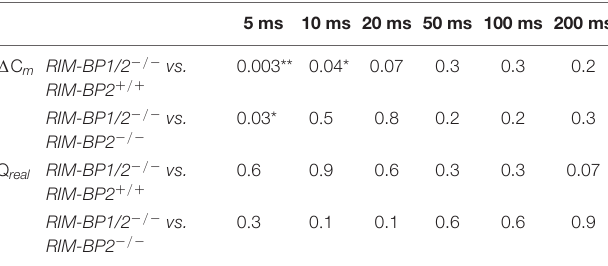
Summary of statistical analysis of patch-clamp measurement data ( Figure 2B ): Membrane capacitance changes ( (cid:49) C m , upper columns) and the corresponding whole-cell Ca 2 + -current integrals (Q Ca , lower columns) during various depolarization durations (5–200 ms) were compared between IHCs of different genotypes: RIM-BP1/2-deficient (RIM-BP1/2 − / − , n = 8), RIM-BP2-deficient (RIM-BP2 − / − , n = 10) and control (RIM-BP2 + / + , n = 12). p-values from one-way ANOVA and post hoc Tukey’s test; significance level: n.s. p ≥ 0.05, *p < 0.05, **p < 0.01. Data of RIM-BP2-deficient (RIM-BP2 − / − ) and control (RIM-BP2 + / +